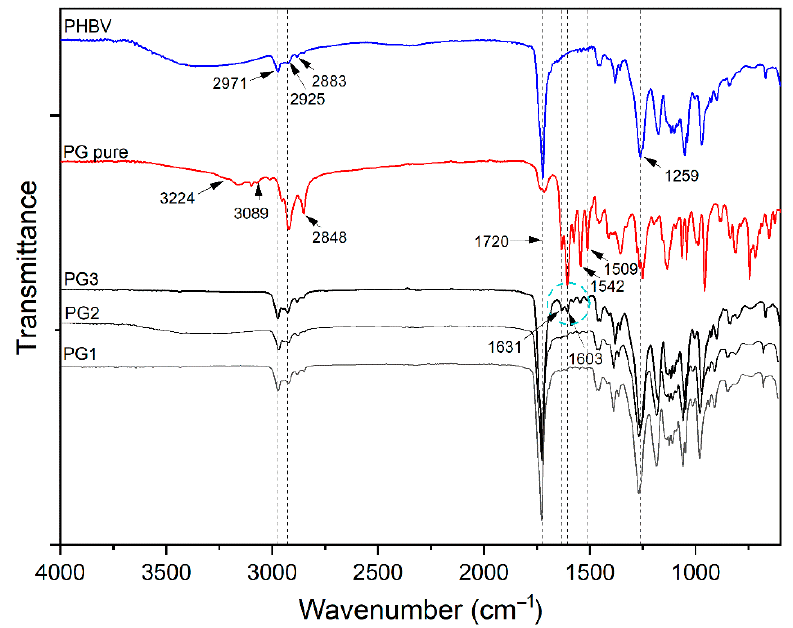
Figure 3. FTIR analysis of PHBV, pure biopigment prodigiosin (PG pure) and PG1–3 films.